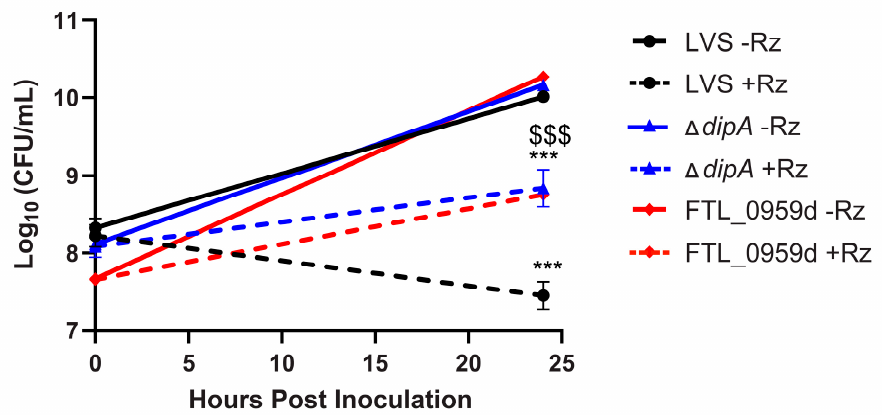
Figure 1. Reduced killing of FTL_0959d and ∆ dipA by resazurin compared to wild-type LVS. Bacteria were cultivated in tryptic soy broth supplemented with 0.1% cysteine HCl (TSBc) in the presence or absence of resazurin (Rz, 1.375 µ g/mL) for 24 h. Cultures were then diluted and plated to determine the number of viable F. tularensis LVS bacteria 24 h post inoculation. Data shown are mean ± SEM from three individual experiments. The limit of detection was 100 CFU per ml. Statistically significant differences in growth post-inoculation were determined by two-way ANOVA followed by Tukey’s multiple comparisons test (***, p < 0.001 comparing +Rz to − Rz for each strain; $$$, p < 0.001 comparing FTL_0959d and Δ dipA to LVS 24 h. post Rz treatment).